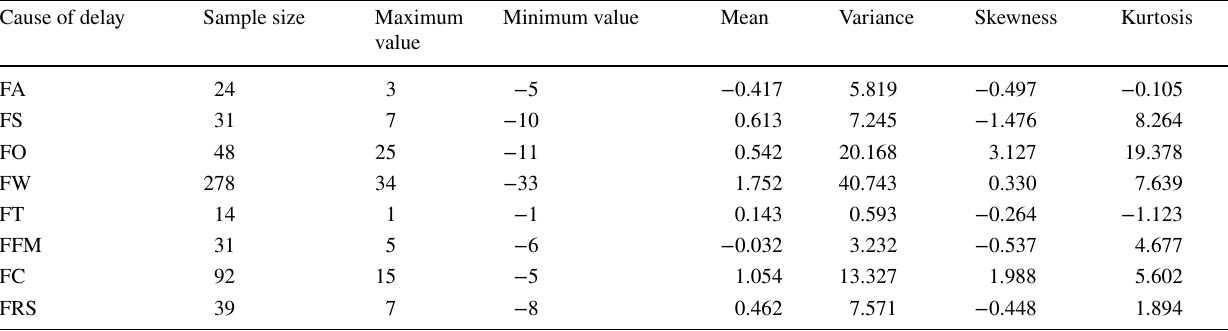
Table 2 Descriptive statistics of the delay increase and recovery of the train at the following stations under different causes Cause of